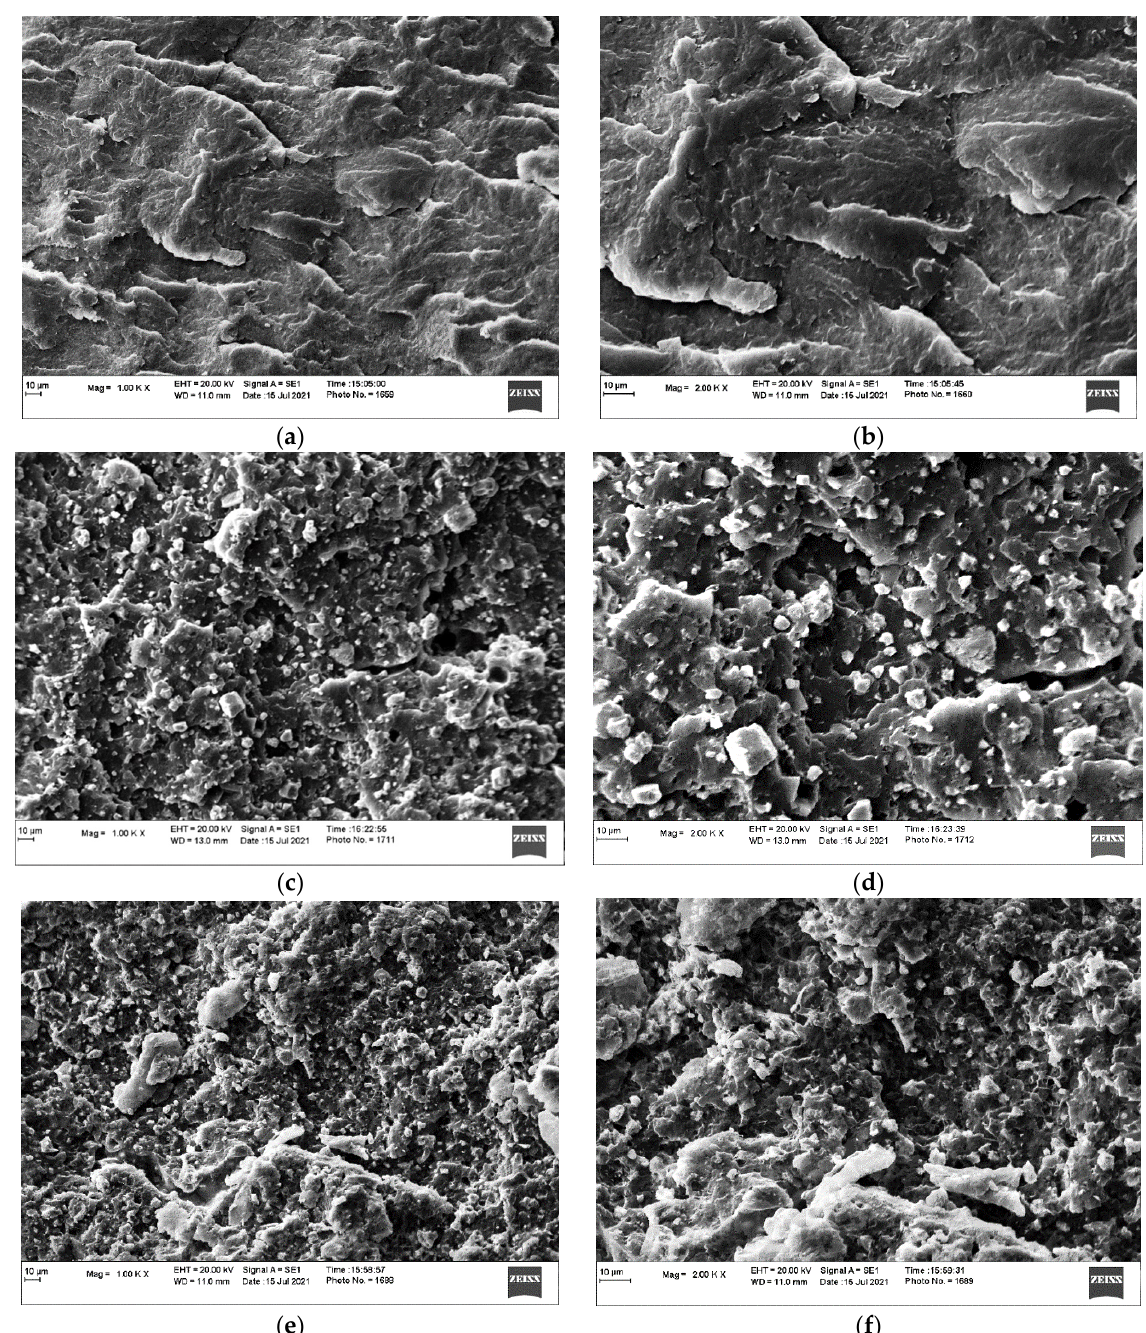
Figure 9. SEM micrographs of HPP: ( a , b ), 30 wt.% CaCO 3 filled HPP: ( c , d ), and 40 wt.% CaCO 3 filled HPP ( e , f ).